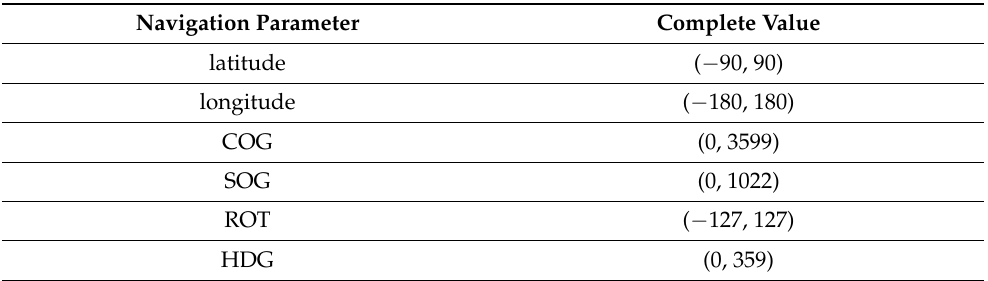
Table 2. Values applied in the case of complete dynamic data in AIS position reports sent by class A